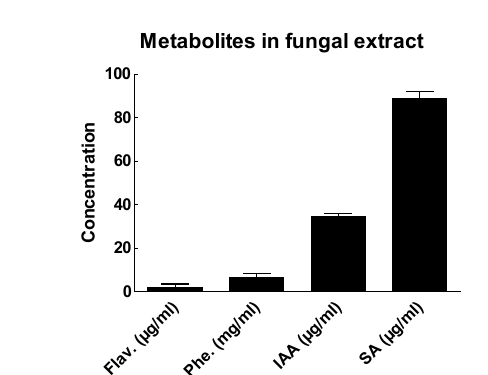
Fig. 1: Phylogenetic harmony tree construction (11 taxa, 10 reference and 1 clone) for the identification of fungal isolate DryL-1 using neigh- bor joining (NJ) method. 49% bootstrap value confirmed isolate DryL-1 as Aspergillus violaceofuscus .